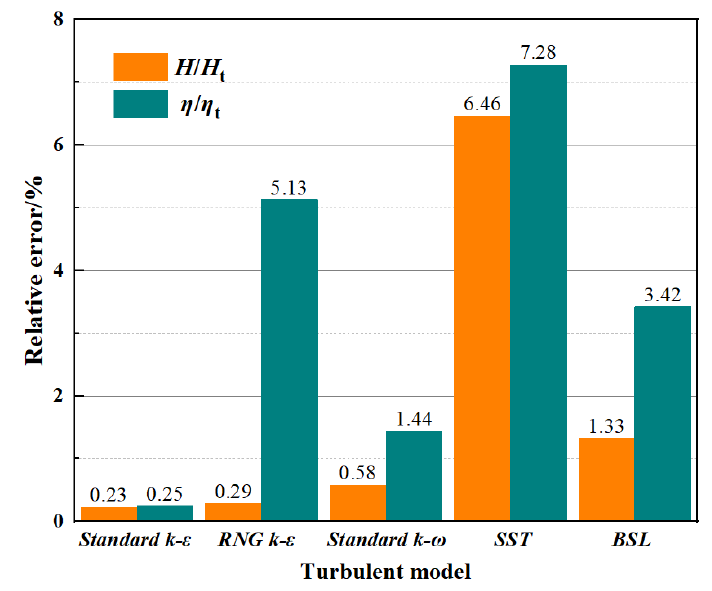
Figure 5. Comparison of relative error values of turbulence models.